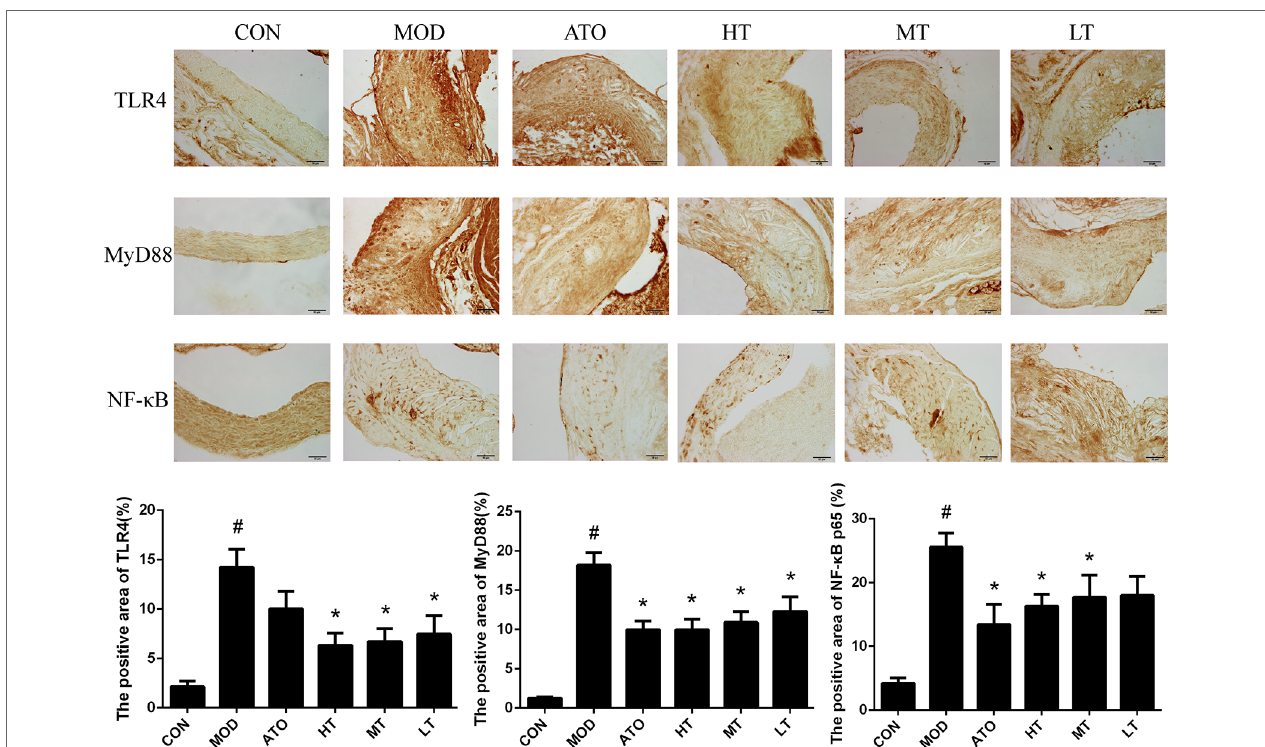
FIGURE 5 | Effects of Tan IIA treatment on the expression of TLR4, MyD88, and nuclear factor-kappa B (NF- κ B) in plaque in aortic root of ApoE −/− mice by immunohistochemistry and the positive area of TLR4, MyD88, and NF- κ B p65 in plaque by immunohistochemistry. Data are expressed as mean ± SEM. n = 12 (except CON group, n = 9). * P < 0.05 versus MOD group; # P < 0.05 versus CON group.